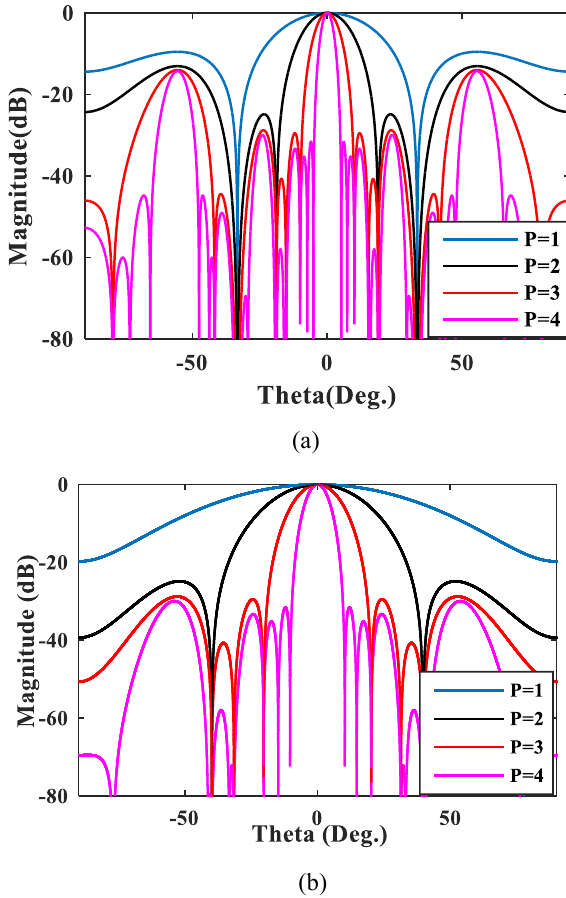
Figure 8. Array factors of triangular fractal planar array antennas generated by concentric (a) elliptical and (b) circular ring sub array generators for S=2 up to four